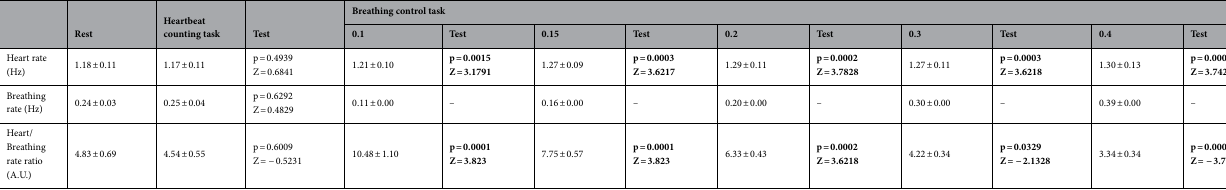
Table 1. Group median + MAD of the average heart and breathing rates in each experimental condition. p-values were computed using the paired Wilcoxon test during each session with respect to the resting condition. Significant values are in bold.